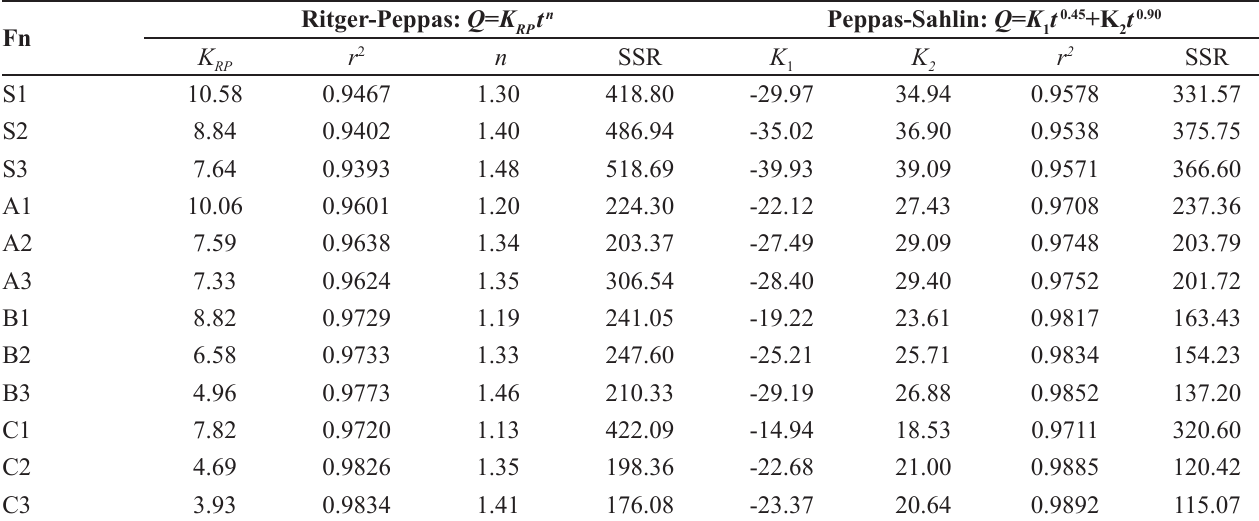
TABLE VI - Parameter and correlation coefficients for Ritger-Peppas and Peppas-Sahlin models